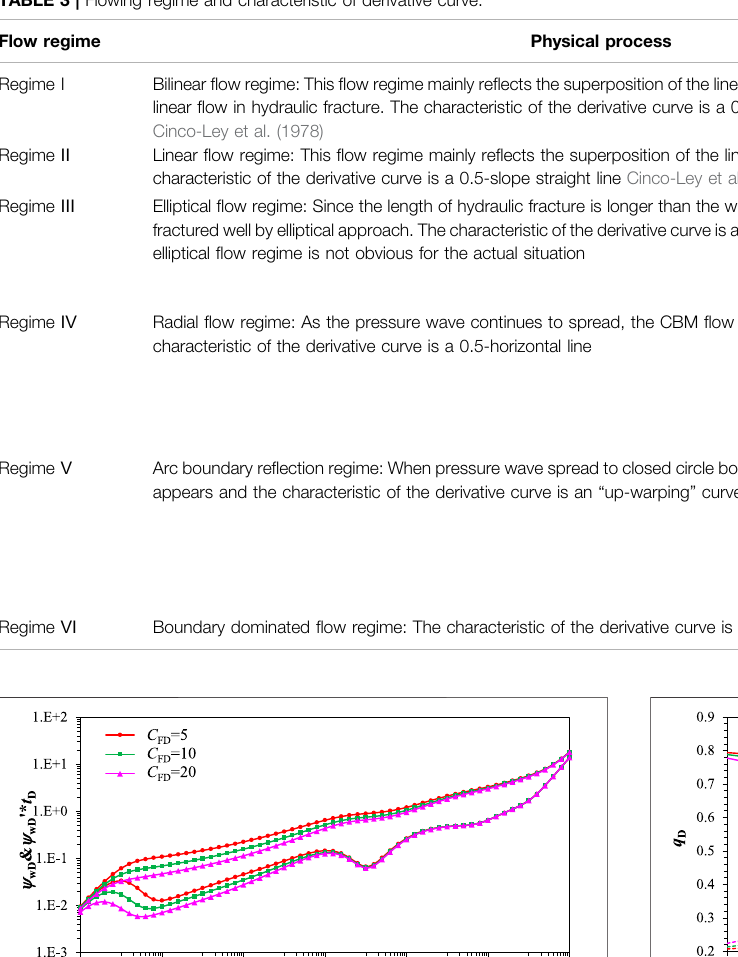
TABLE 3 | Flowing regime and characteristic of derivative curve.